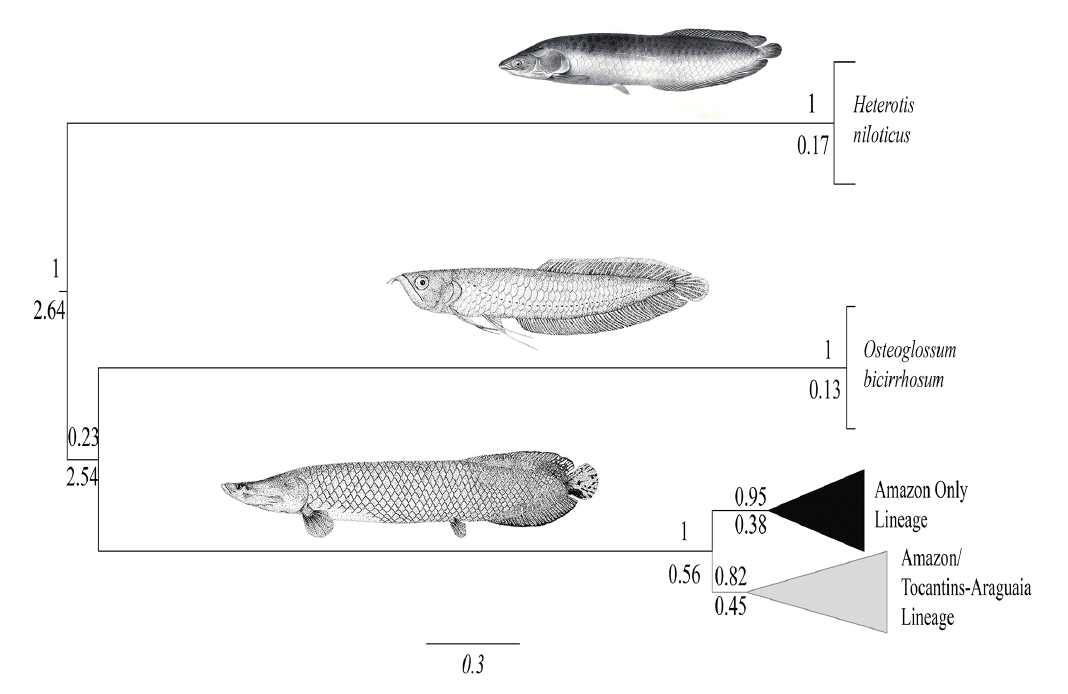
Figure 3. Topology showing the evolutionary relationships among Osteoglossidae taxa, based on the analysis of the Cytb gene, by Bayesian Inference. The values above the nodes show the statistical support, while those below the nodes indicate the mean coalescence time (Kyr). Illustrative picture of the Boulenger (1907) and MUSA